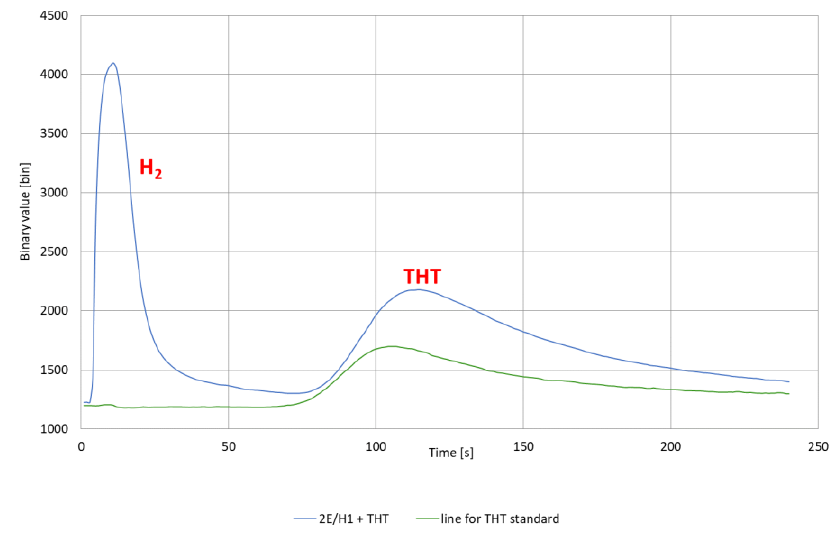
Figure 5. A sample chromatogram obtained using a Type I analyzer for M/H1 + THT, c THT = 9.40 ± 0.47 ppm.